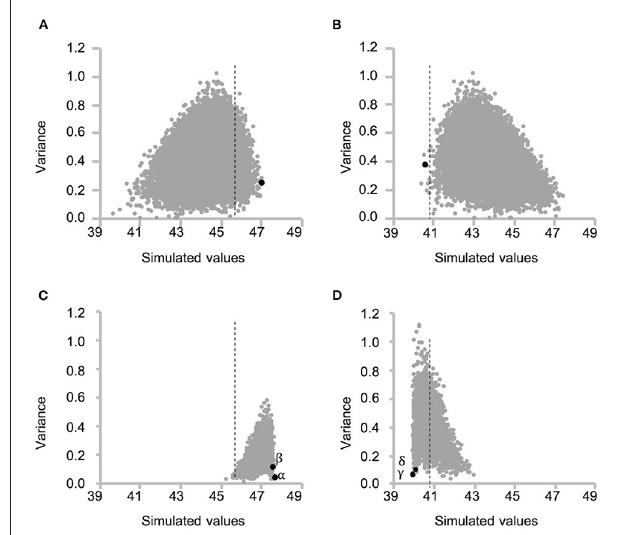
FIGURE 5 | Scatter plot of the mean and variance of simulated protein content of each F 2 population for all possible cross combinations between recombinant inbred lines (RILs). Each grey dot indicates each cross combination. (A, C) and (B, D) indicate selection toward higher and lower seed protein content, respectively. (A) and ( B ) indicate the variation of the mean of top 5% of F 2 plants ( A ) and bottom 5% of F 2 plants ( B ) and variance of F 2 population for each cross combination at the first selection cycle. The dashed lines indicate the highest (A, C) or lowest (B, D) estimated value among RILs. Selected best cross combination toward higher [ (A) RIL048 × RIL176] and lower [ (B) RIL047 × RIL097] protein content is shown in black dot. (C, D) indicate variation of the mean and variance at the second selection cycle from the cross combination of (A) and (B) , respectively. Greek letters ( α − δ ) beside the black dots indicate identifiers for the cross combination in the following Figures 6 , 7